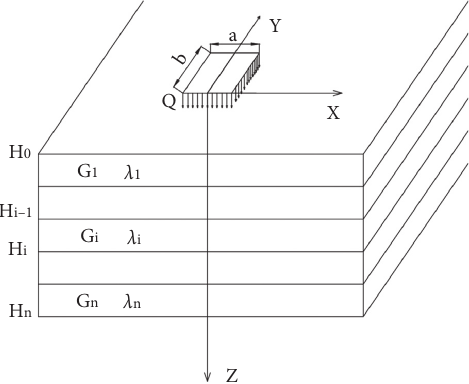
Figure 1: The calculation model of the three-dimensional spatial problem of layered stratum under loading.